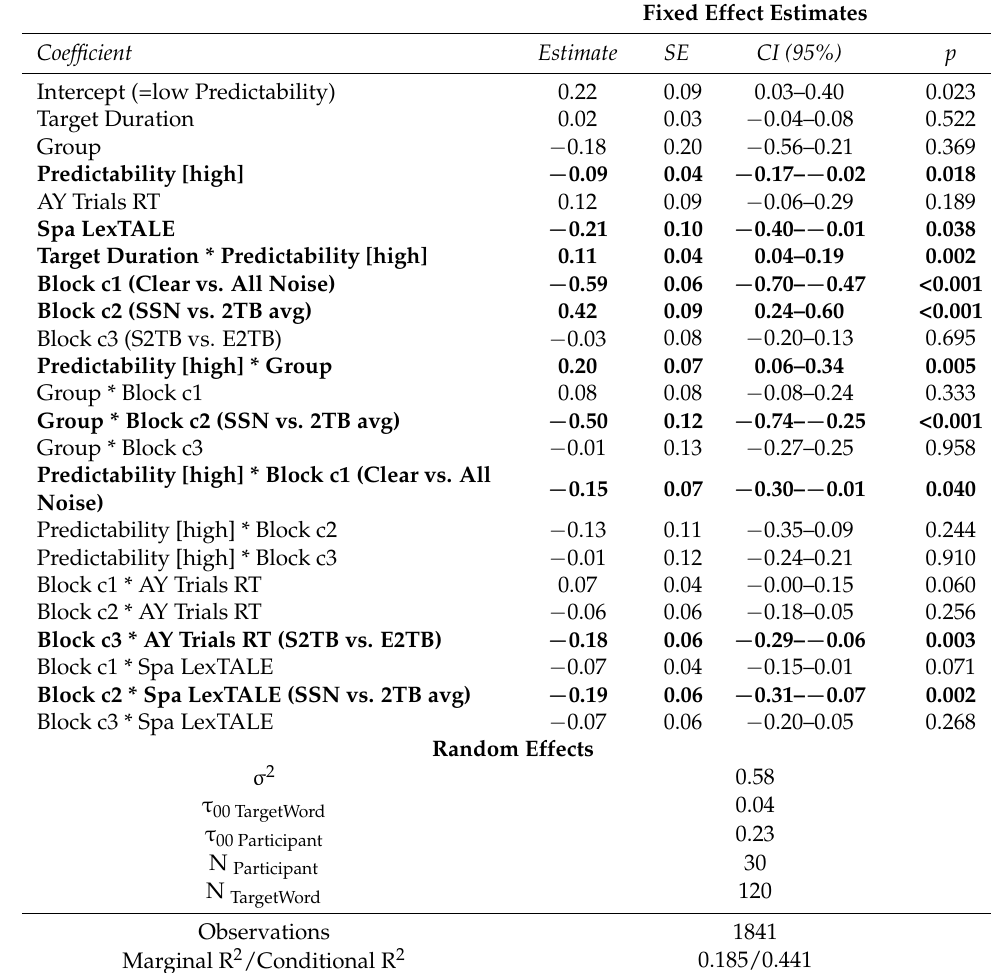
Table 5. Fitted model examining individual differences in reaction times for accurate keyword responses in the speech-in-noise recognition